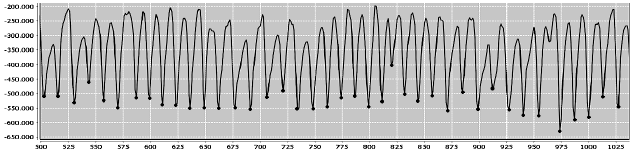
Fig. 3. Raw Data of the frontal (horizontal) acceleration of the waist during normal walking.